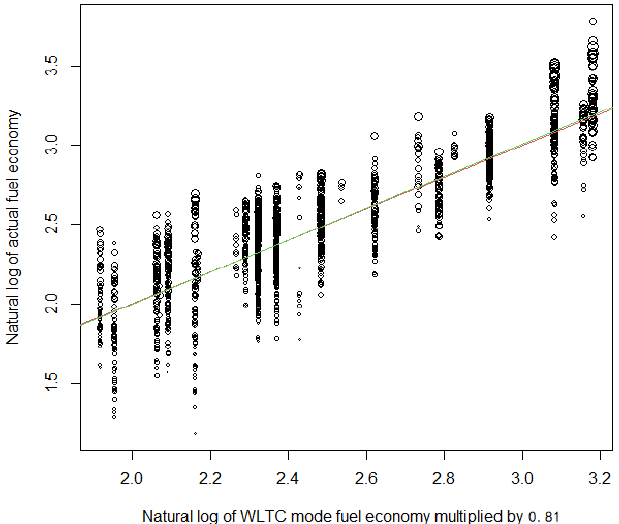
Figure 7. Scatter plot when the WLTC mode fuel economy is multiplied by 0.81. (The size of the circle indicates the distance to refueling).